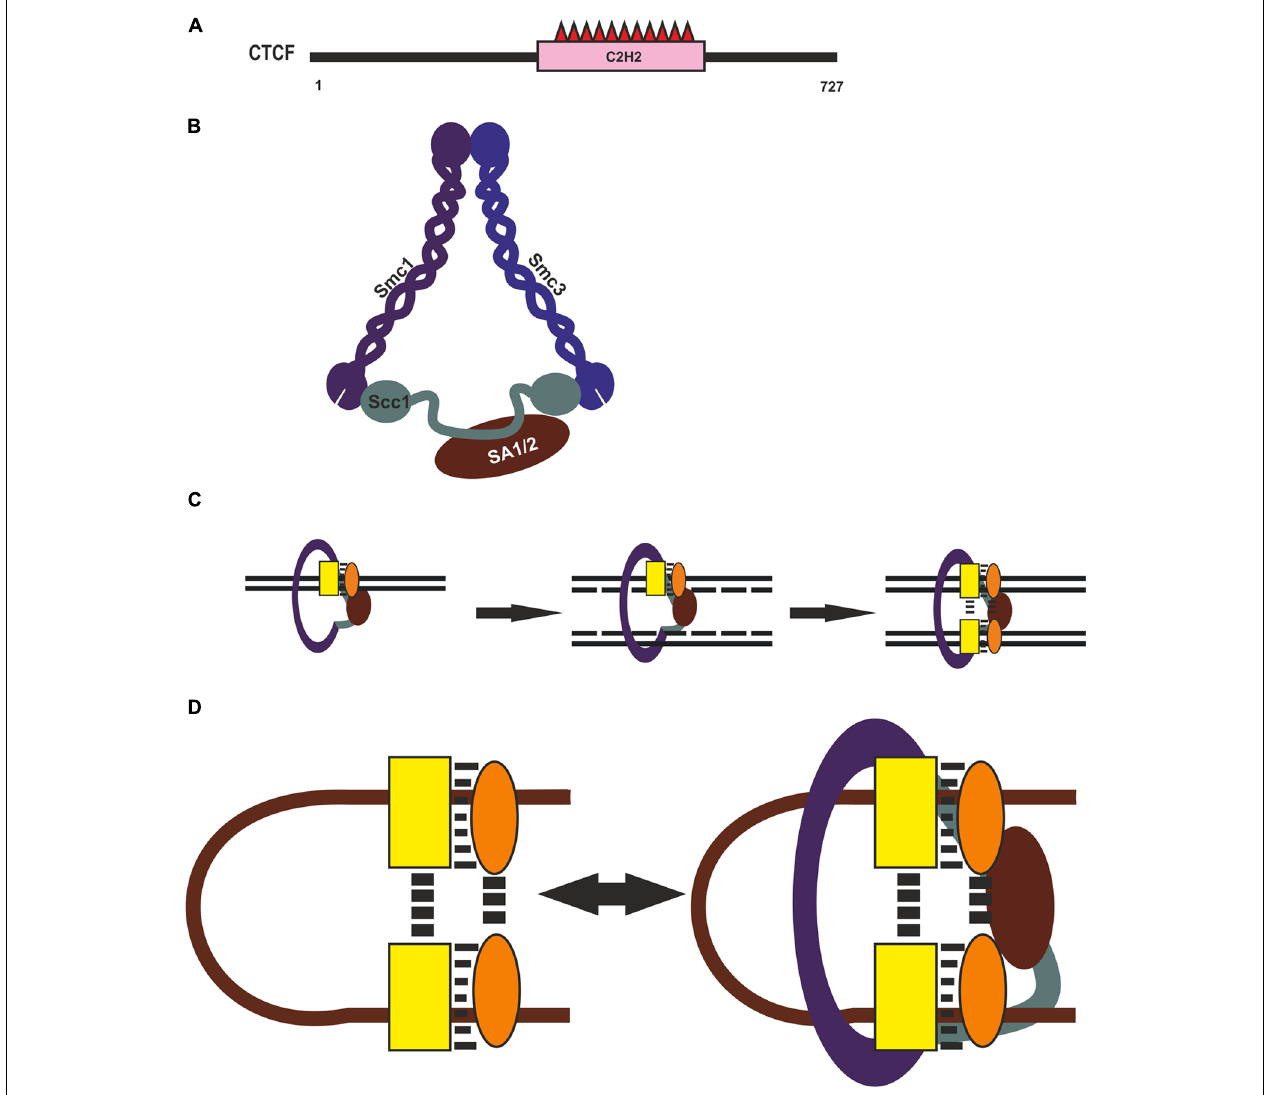
FIGURE 3 | CTCF and cohesin complex in chromatin architecture. (A) Domain organization of CTCF. (B) Cohesin complex. Structural Maintenance of Chromosomes (Smc), Sister Chromatid Cohesion (Scc), Stromal Antigen (SA). (C) Possible role of Cohesin in reproducing of CTCF